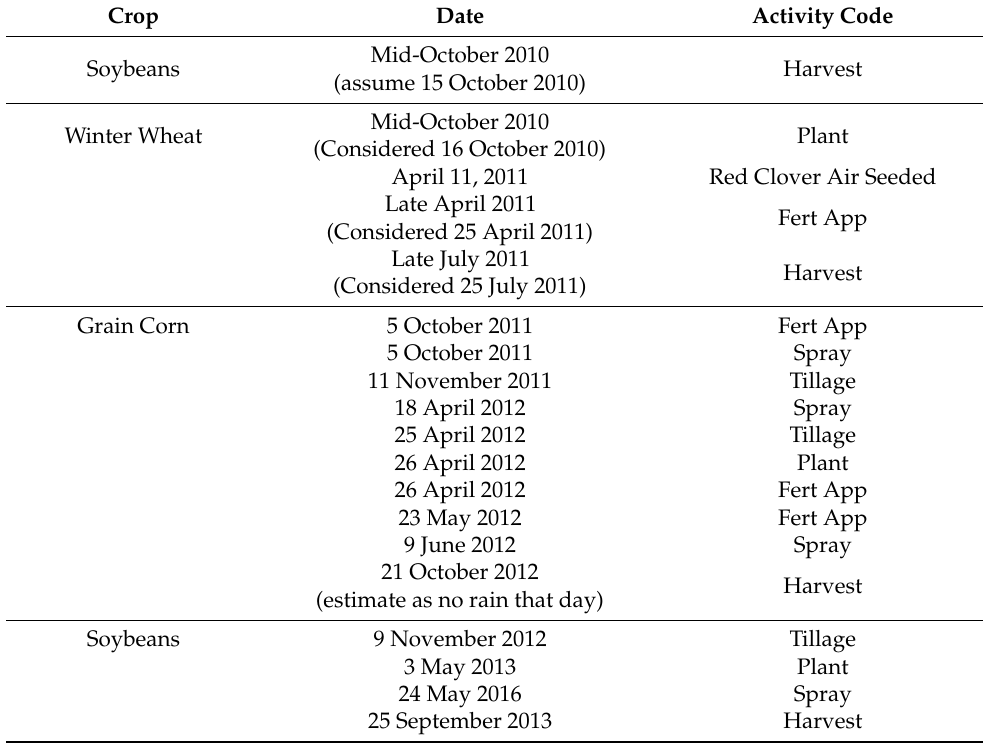
Table 2. Management practices considered in the